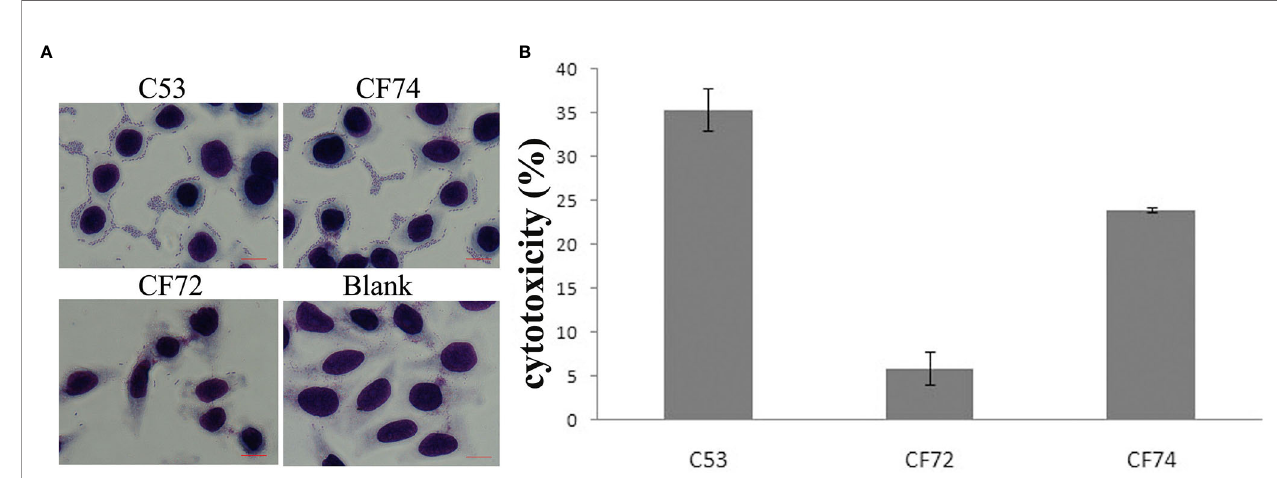
FIGURE 4 | HEp-2 cell adhesion and cytotoxicity of Citrobacter isolates. (A) Light micrographs show the adherence patterns displayed by one strongly cytotoxic Citrobacter isolate (C53). Cells were stained with 1% Giemsa stain and examined under a light transmission microscope at a magni fi cation of ×1,000. HEp-2 cell nuclei and bacteria were stained purple. C . freundii strain CF74 was used as highly adhesive control, C. freundii strain CF72 as lowly adhesive control, and Blank which had no bacteria as negative control. C53 displayed patterns of aggregative adherence to HEp-2 cells similar to CF74. Few bacteria were seen aggregated around HEp-2 cells in CF72. Bar: 10 µm. (B) Cytotoxicity of one highly cytotoxic Citrobacter isolate (C53) which was based on the LDH released from HEp-2 cells after exposure at 8 h. CF72 was used as lowly cytotoxic control strain and CF74 as highly cytotoxic strain. Y- axis is percentage of LDH released as measure of